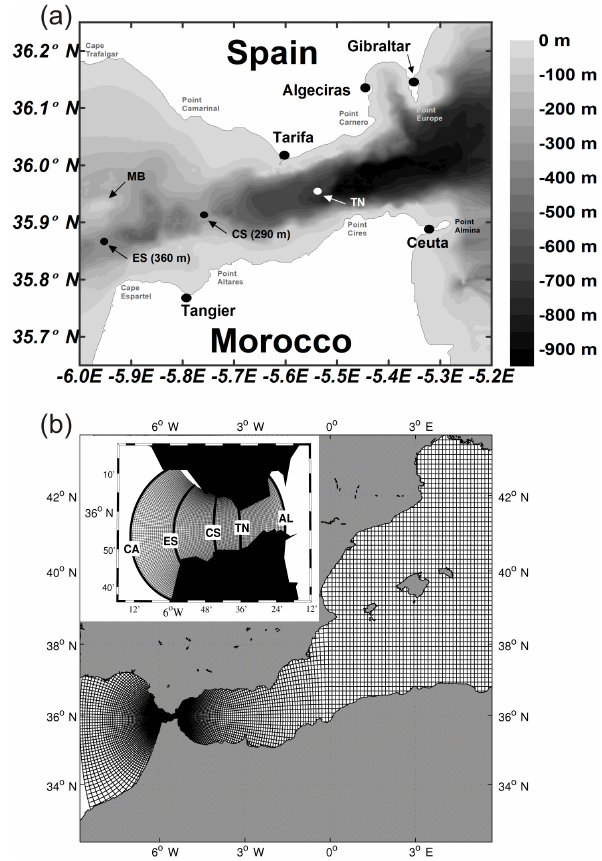
Figure 1. (a) Map of the Strait of Gibraltar showing the main topo- graphic features: Espartel Sill (ES), Camarinal Sill (CS) and Tarifa Narrows (TN). MB indicates the submarine ridge of Majuan Bank, which divides the Espartel section into two channels: the main chan- nel to the south and a secondary one to the north. (b) Representation of the model grid with the refinement around the Gibraltar strait. The inset shows the five cross-strait sections investigated: Gulf of Cádiz (CA), Espartel (ES), Camarinal Sill (CS), Tarifa Narrows (TN) and Alboran Sea